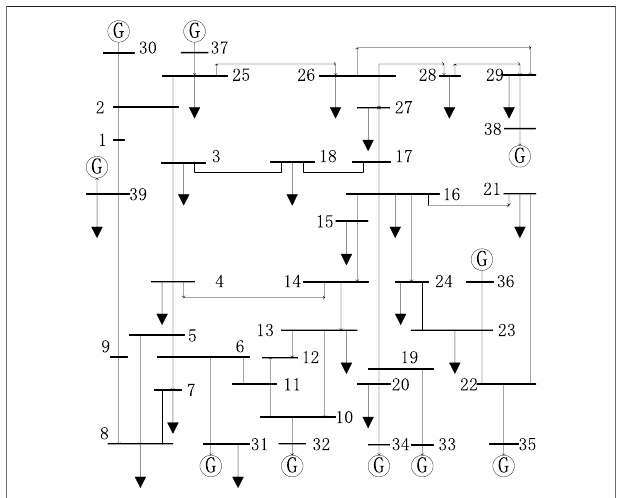
FIGURE 4 | Single line diagram of the IEEE 39-bus system.